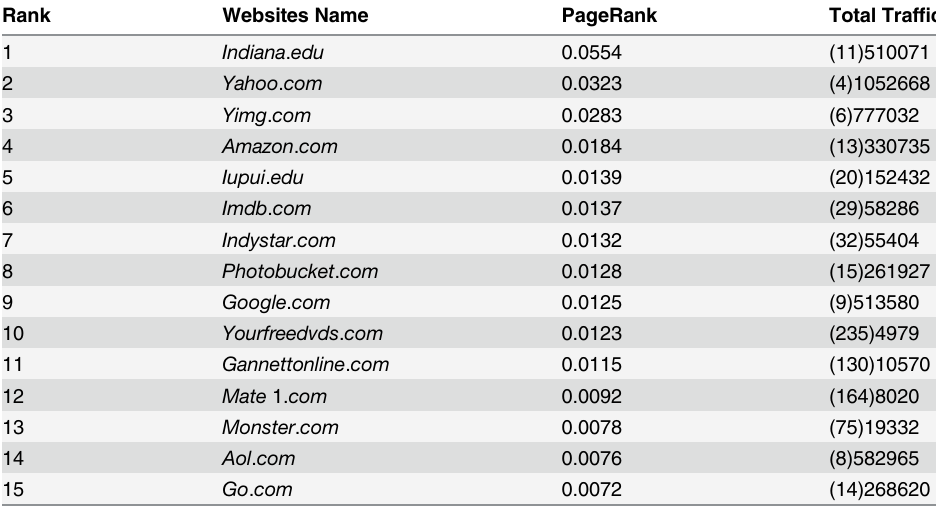
Table 3. Top 15 websites with highest